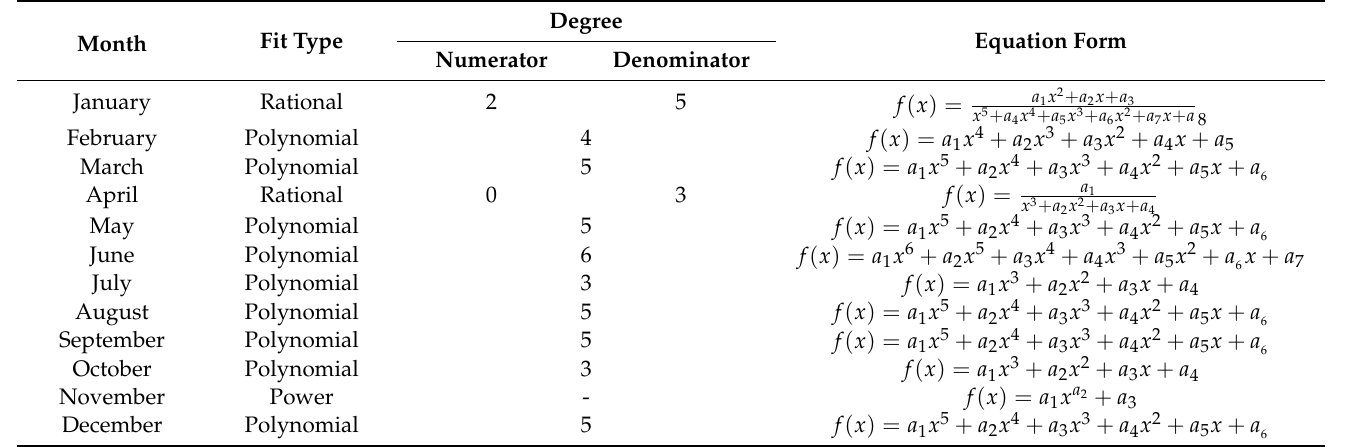
Table A5. Fit type and equation form of Sinan section.